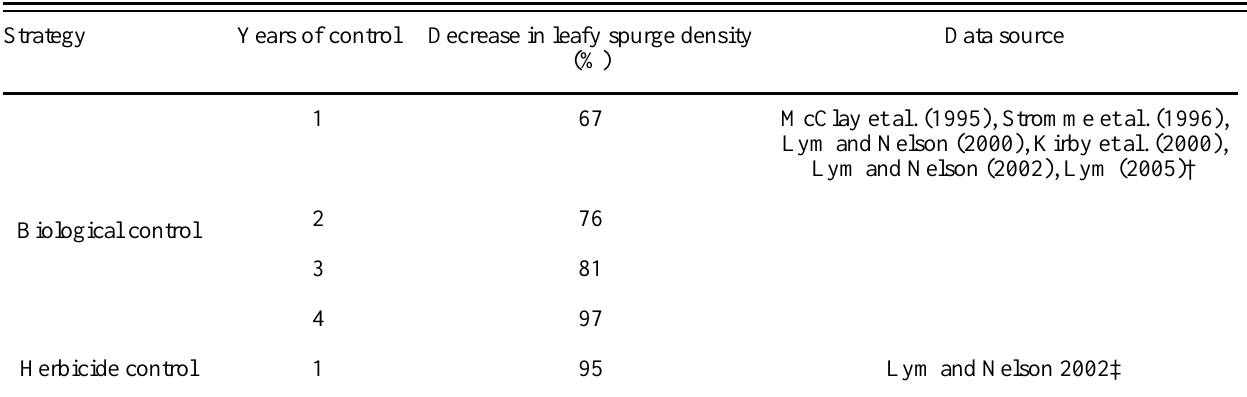
Table 3. Control of leafy spurge density using biological control and herbicide control